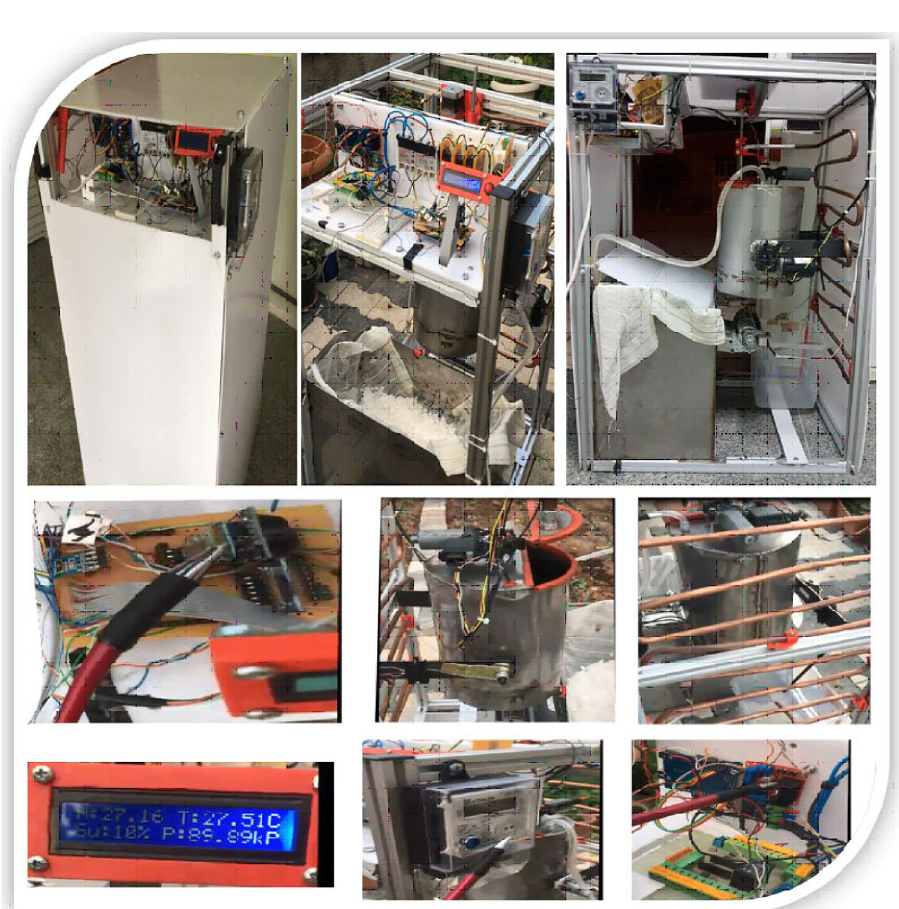
Fig. 2 View of the system’s